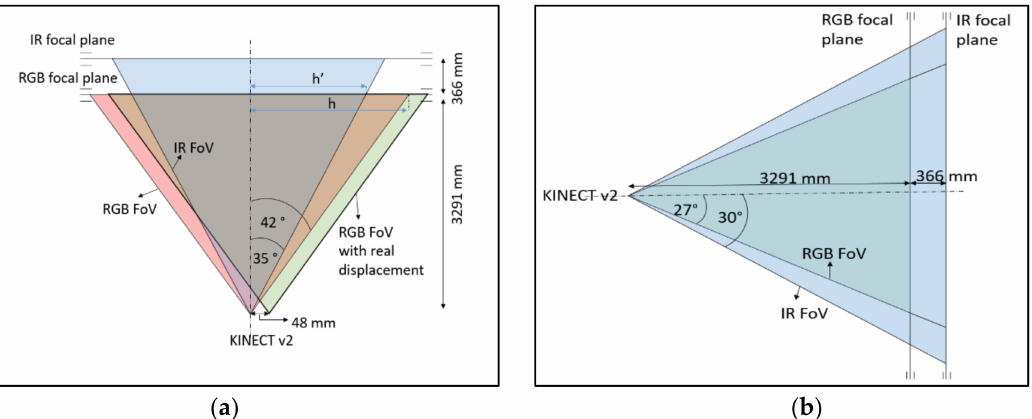
Figure 9. Diagram of the properties of the RGB and the depth cameras of the Kinect v2. ( a ) Properties of the horizontal field of view and focal plane distances for RGB and IR cameras. ( b ) Properties of the vertical field of view and focal plane distances for RGB and IR